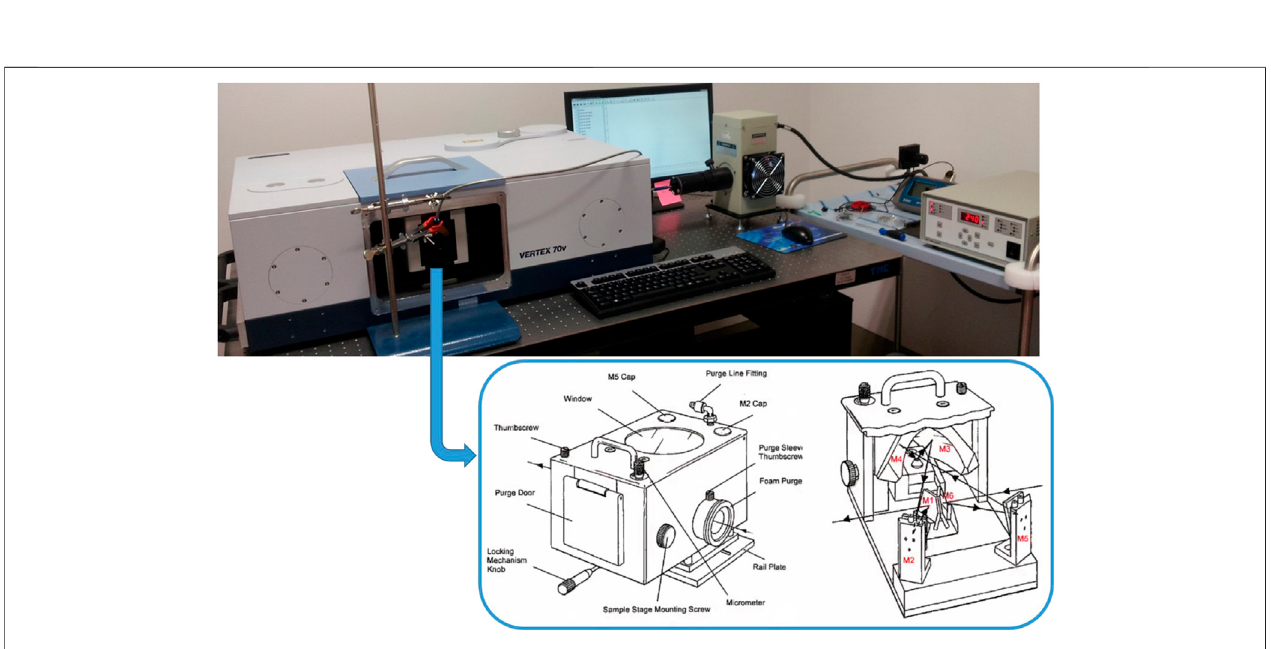
FIGURE 2 | Experimental setup used for in situ UV irradiation experiments, with scheme of the Praying Mantis TM Diffuse Re fl ection Accessory.